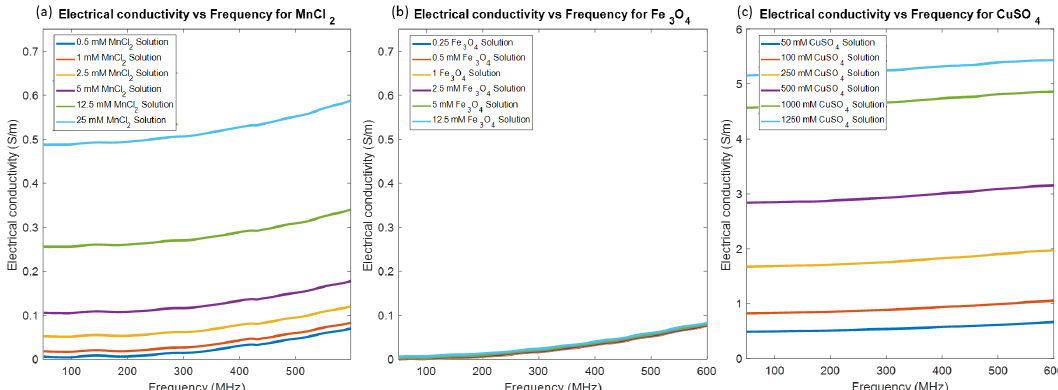
Figure 2. Electrical conductivity over the investigated frequency band for different ( a ) MnCl 2 , ( b ) Fe 3 O 4 , and ( c ) CuSO 4 concentrations. Note that the scale in figure ( c ) is